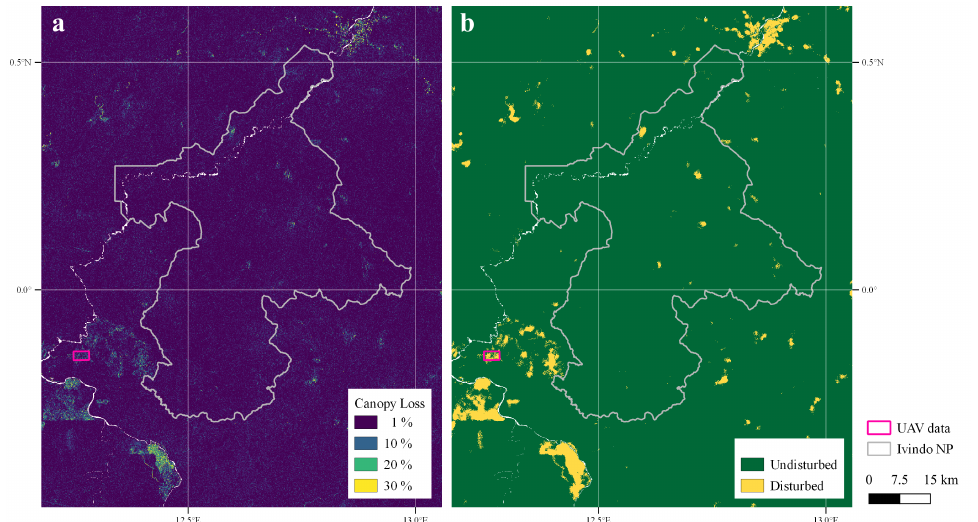
Figure 9. ( a ) Gross canopy cover loss per 1 ha cell in and around Ivindo National Park (marked by grey boundary), estimated by Sentinel-1 shadows for the year 2020; ( b ) classification of the same area into undisturbed (green) and disturbed (yellow) forest. The field site where UAV LiDAR was obtained is indicated in pink.